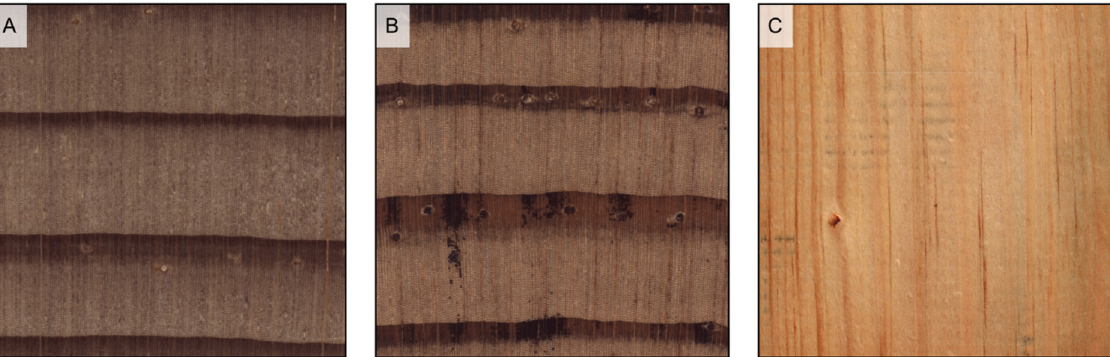
Figure 17. Axial canals in softwoods (all transverse sections except C ). ( A ) axial canals small ( Picea engelmannii ); ( B ) axial canals large ( Pinus rigida ); ( C ) vertical streaks on a longitudinal surface determined by axial canals ( Pinus chihuahuana ).